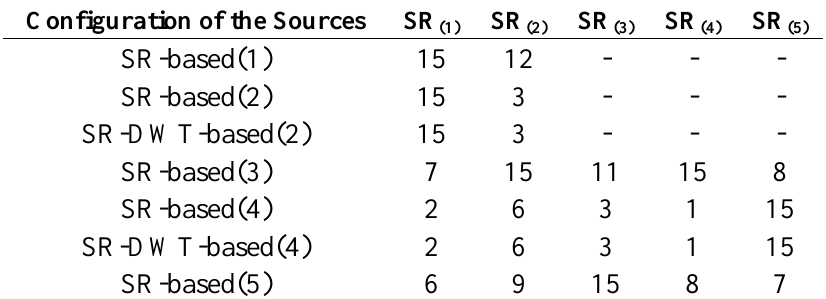
Table 5. Sensing relevancies